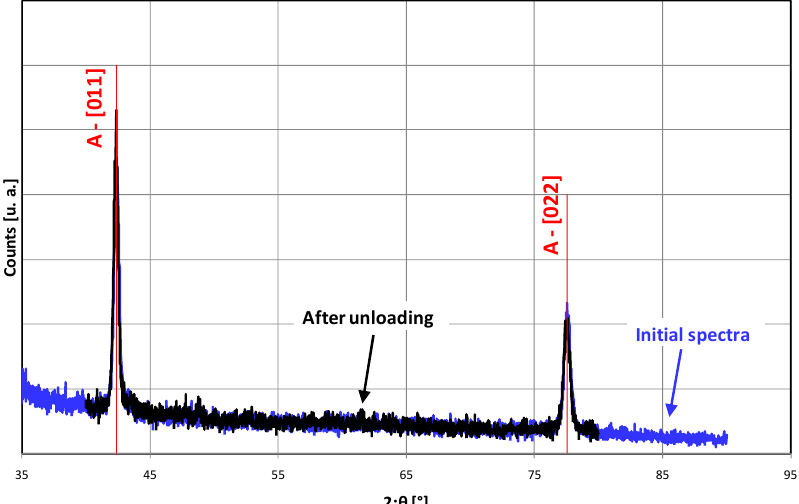
Figure 12: Comparison of the X-Ray spectra between initial condition and final stress free condition after